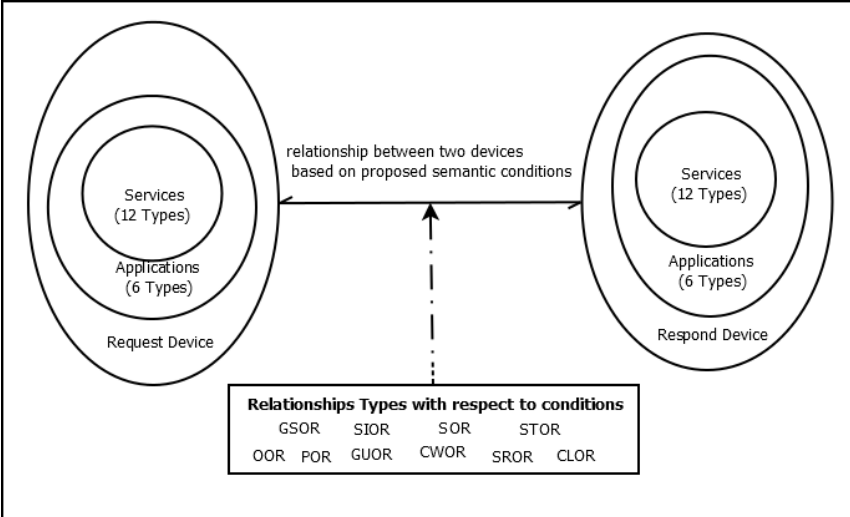
Figure 2. Proposed process